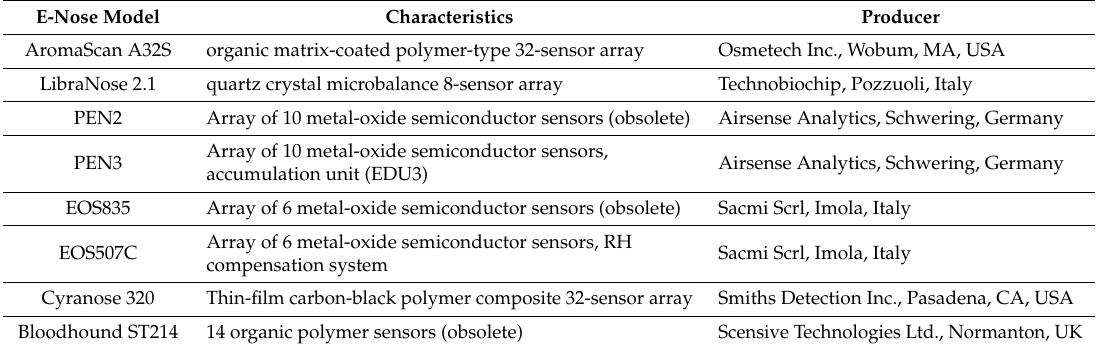
Table 2. List of commercial e-nose models employed for plant pathogen and pest